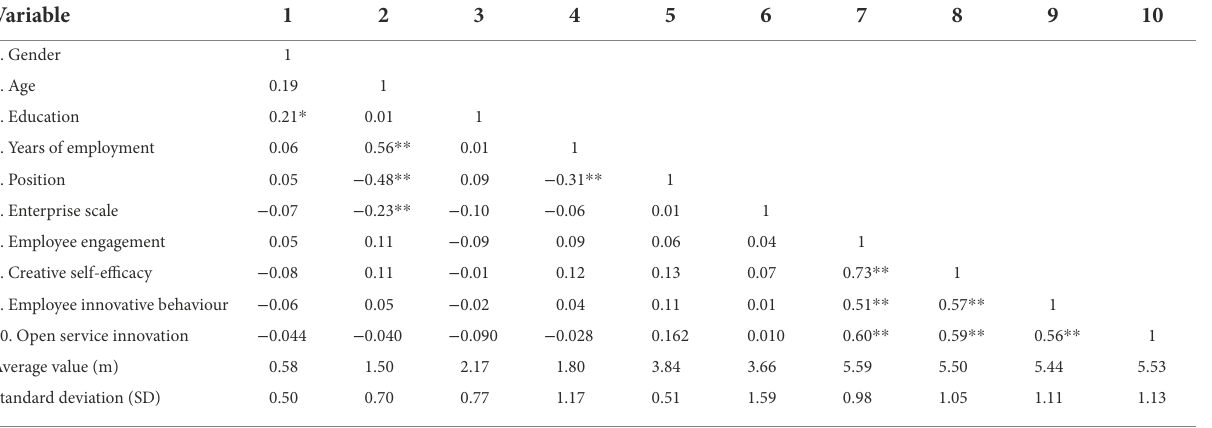
TABLE 2 Mean value, standard deviation, and correlation coefficient among main variables.